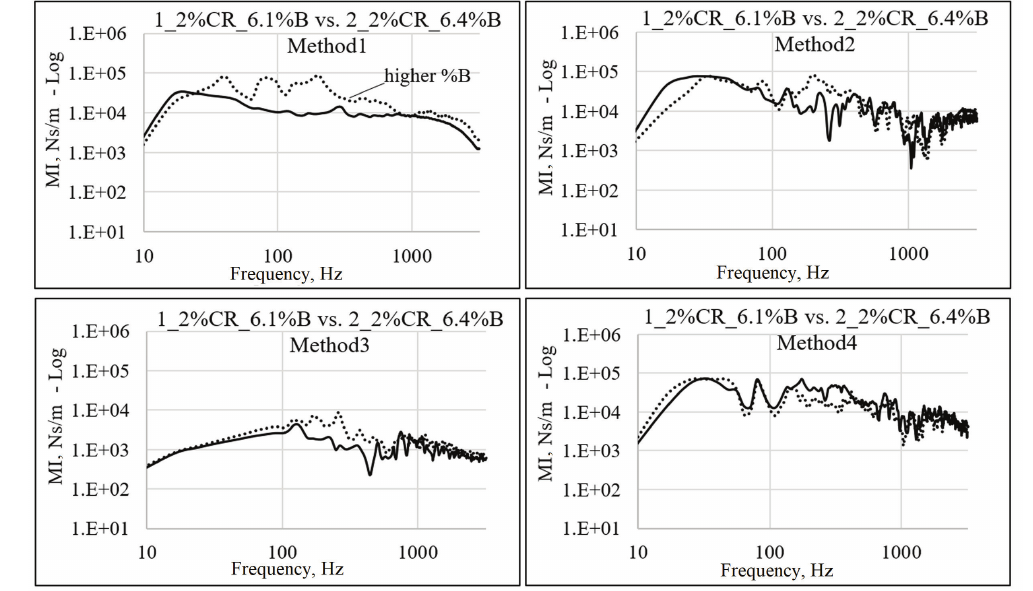
Figure 11. Comparison of Mechanical Impedance between 6.1% and 6.4% of bitumen considering the four methods